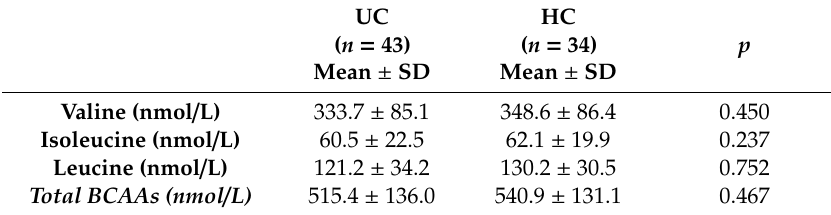
Table 2. Comparison of plasma branched-chain amino acids (BCAAs) between the UC patients and HC.